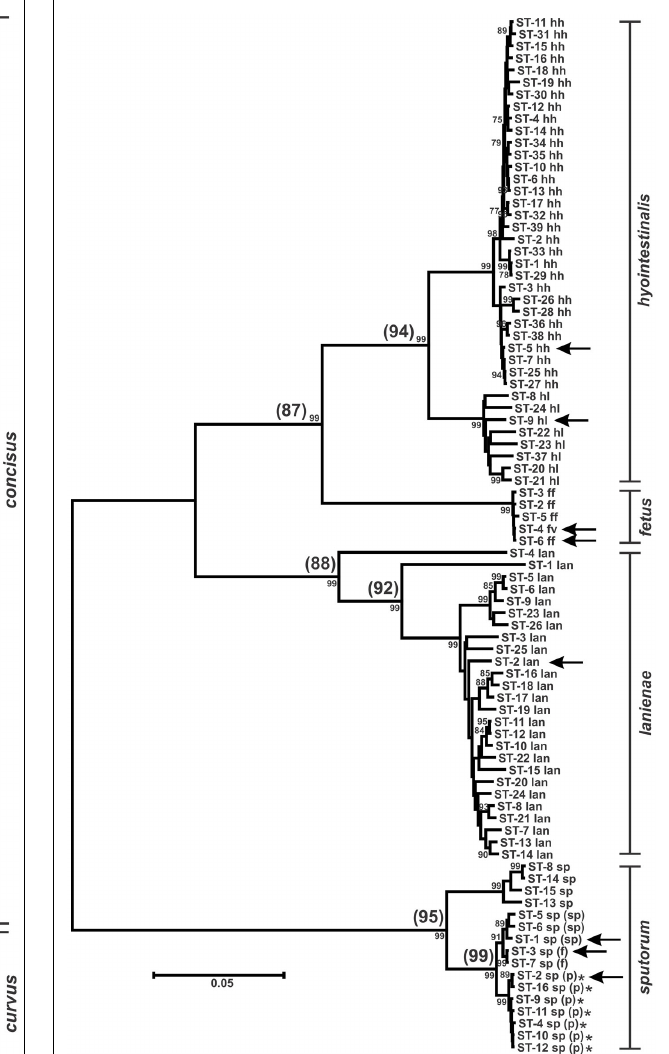
FIGURE 2 | Dendrogram of C. hyointestinalis , C. fetus , C. lanienae , and C. sputorum STs. Allele sequences for each strain were concatenated in the order aspA - atpA - glnA - gltA - glyA - pgm - tkt and aligned using CLUSTALX . The dendrogram was constructed using the neighbor-joining algorithm and the Kimura two-parameter distance estimation method (Kimura, 1980). Bootstrap values > 75%, generated from 1000 replicates, are shown at the nodes. Scale bar represents substitutions per site. ST labels indicate taxon: hh, C. hyointestinalis subsp. hyointestinalis ; hl, C. hyointestinalis subsp. lawsonii ; ff, C. fetus subsp. fetus ; fv, C. fetus subsp. venerealis ; lan, C. lanienae ; sp, C. sputorum ; sp (sp), C. sputorum bv. sputorum ; sp (f), C. sputorum bv. fecalis ; sp (p), C. sputorum bv. paraureolyticus . Arrows indicate the STs of the genome-sequenced strains for each taxon. ∗ Urease-positive strains.Values in parentheses at the nodes represent the average %nt similarity of the STs split at each node, following pairwise comparisons of the concatenated allele